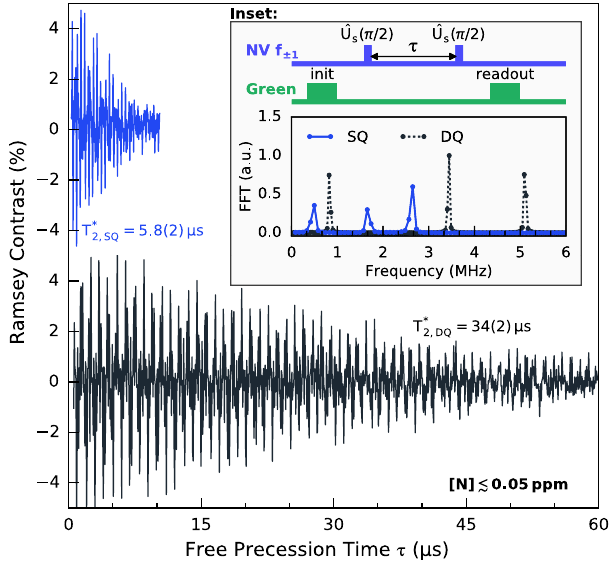
FIG. 2. NV Ramsey measurements for a low nitrogen density sample (sample A, ½ N (cid:5) ≲ 0 . 05 ppm) at an applied bias magnetic field of B 0 ¼ 2 . 2 mT. Comparison of time-domain data and resulting fit values for the NV spin ensemble T (cid:1) 2 for the single quantum (SQ) coherence, f 0 ; þ 1 g (blue, upper) and the double quantum (DQ) coherence, fþ 1 ; − 1 g (black, lower). Upper inset: Illustration of DQ Ramsey protocol with two-tone microwave ˆ U π = 2 Þ is the spin-1 unitary evolution (mw) pulses, where S ¼ 1 ð operator [31]. For SQ measurements, a single-tone mw pulse is applied instead to generate the pseudo-spin- 1 = 2 unitary evolution ˆ U π = 2 Þ . Lower inset: Discrete Fourier transform of operator S ¼ 1 = 2 ð the SQ (solid blue) and DQ (dashed black) Ramsey measure- ments with a mw drive detuned 0.4 MHz from the f 0 ; (cid:4) 1 g transitions. NV sensor spins accumulate phase twice as quickly in the DQ basis as in the SQ